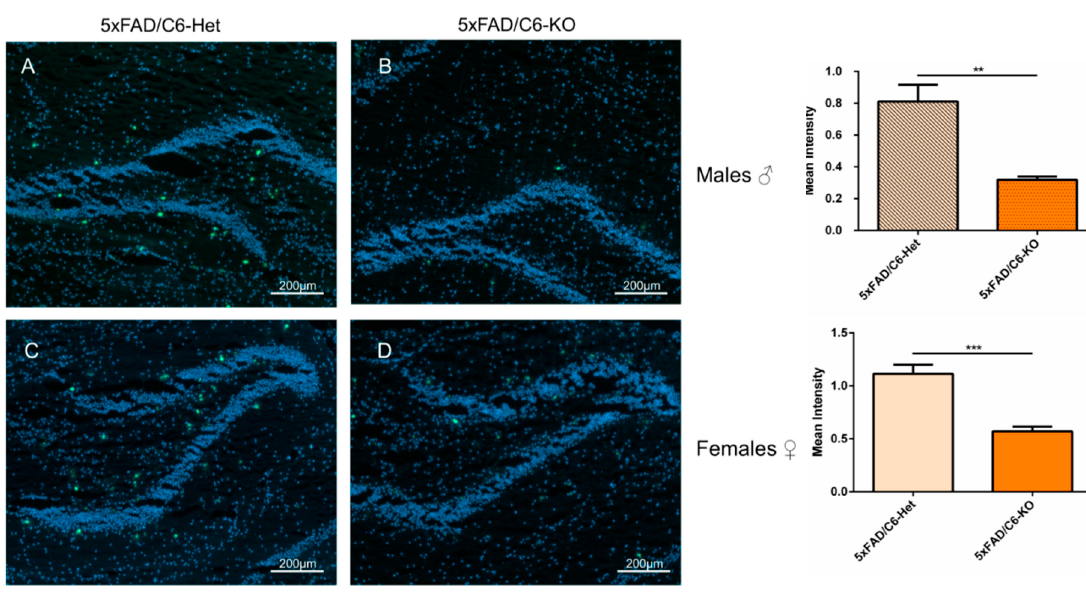
Figure 6. Caspase-6 KO in 5xFAD mice reduces amyloid- β plaque load. Representative images of hippocampal slices stained with ThioS for male ( A – B ) and female ( C – D ) transgenic mice and their respective quantification ( n = 5–7). Scale bar = 200 µ m. Data are mean ± SEM. ** p < 0.01 and *** p < 0.001. Two-tailed t-test.